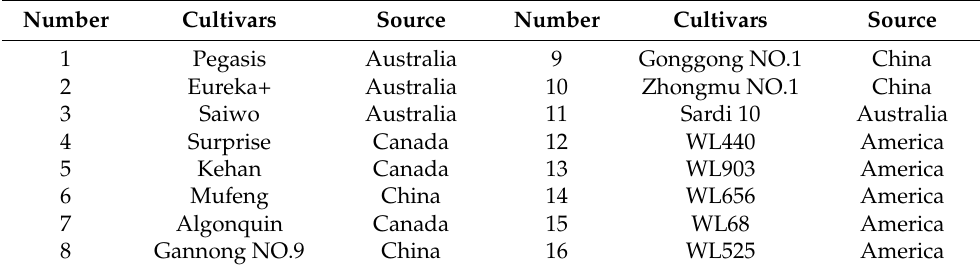
Table 1. The information about the tested 16